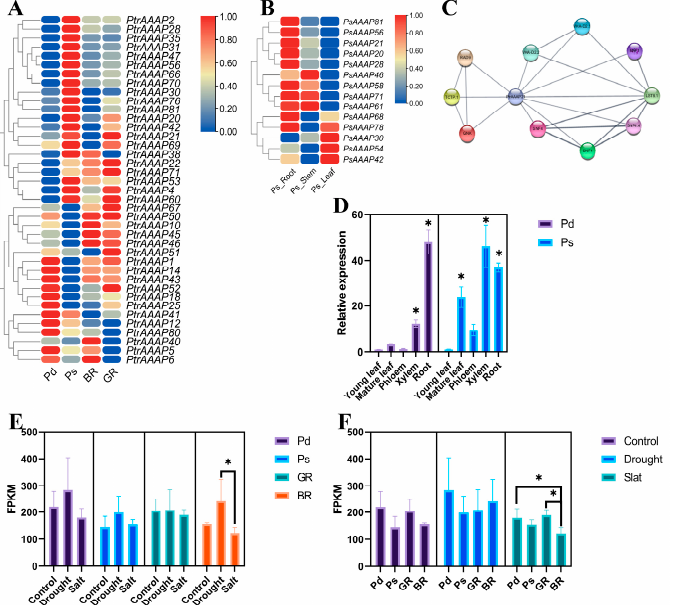
Figure 5. Expression pattern of PtrAAAPs and AAAP21 . ( A ) PtrAAAPs selected from rooting RNA- seq, BR and GR represent average FPKM values of three bad rooting and three good rooting hybrid offspring, respectively. ( B ) Tissue-specific expression of selected PsAAAPs from P. simonii ‘Tongliao1’. RNA was extracted from roots, stems, and leaves, respectively. ( C ) Prediction of genes interacting with PsAAAP21 . ( D ) Tissue-specific expression pattern of P. deltoids ‘Danhong’ and P. simonii ‘Tongliao1’. AAAP21 expression from stress RNA-seq between parents and offspring and response to drought and salt, between ( E ) and between treatment. ( F ) GR: good rooting offspring F64, BR: bad rooting offspring F75. Pd: Populus deltoides ‘Danhong’, Ps: Populus simonii ‘Tongliao1’ and analysis based on ANOVA * p <